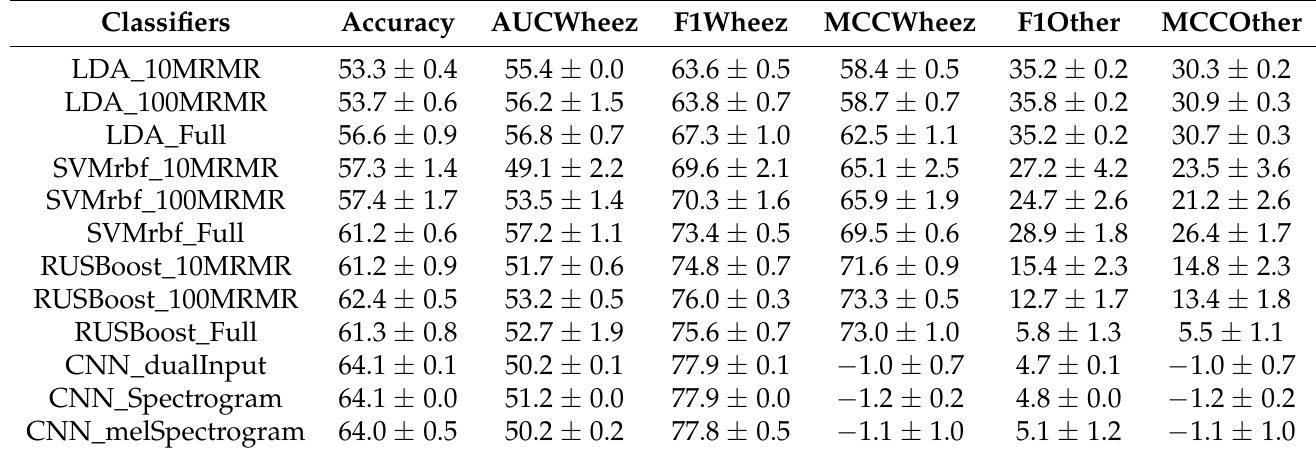
Table 13. Performance results obtained with 2 classes (wheeze vs. other)—training: fixed duration; testing: variable